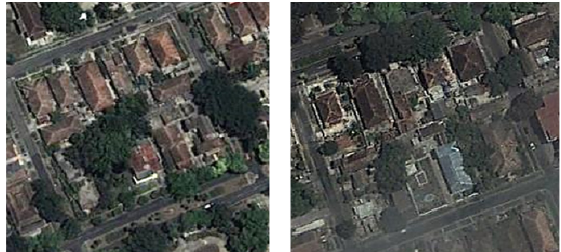
Figure 8. Comparison between two blocks. Note in the right image the reduction of green areas at the interior of the block. Source: Google Satellite-OpenLayers plugin in